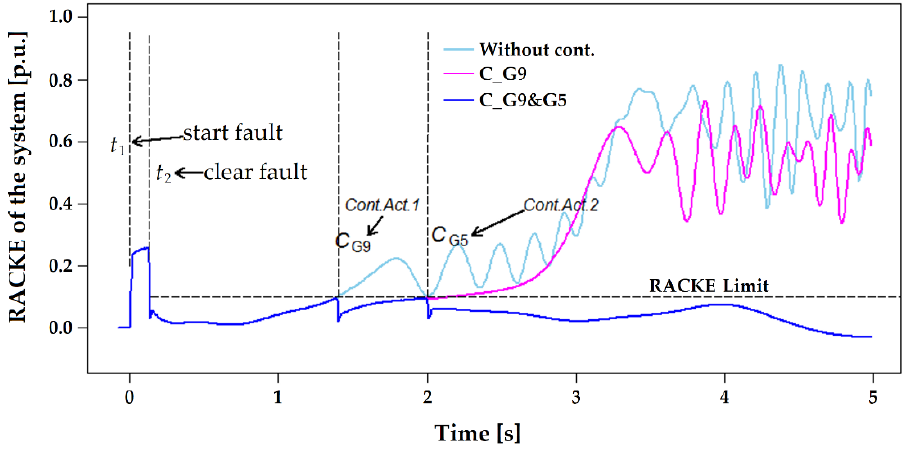
Figure 17. RACKE_SIS vs. time, with and without control.